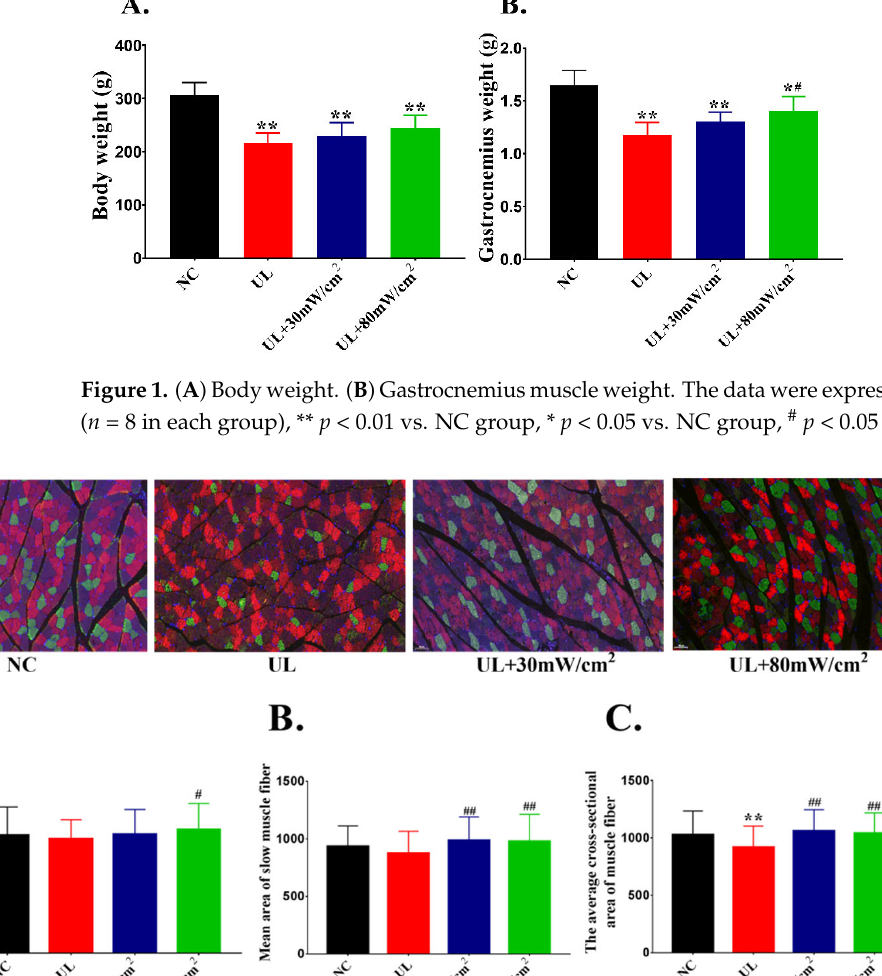
Figure 1. ( A ) Body weight. ( B ) Gastrocnemius muscle weight. The data were expressed as mean ± SD ( n = 8 in each group), ** p < 0.01 vs. NC group, * p < 0.05 vs. NC group, # p < 0.05 vs. UL group.